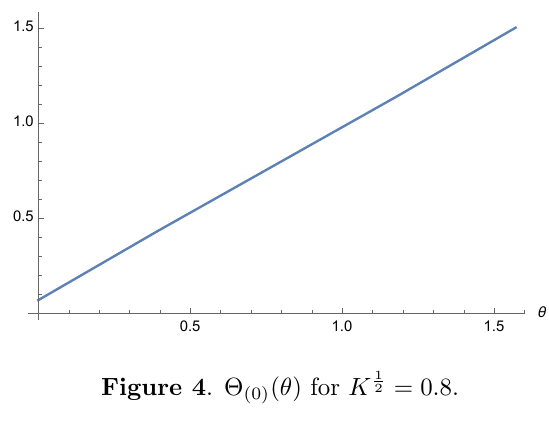
( (cid:18) ) for K 1 2 = 0 : (0)